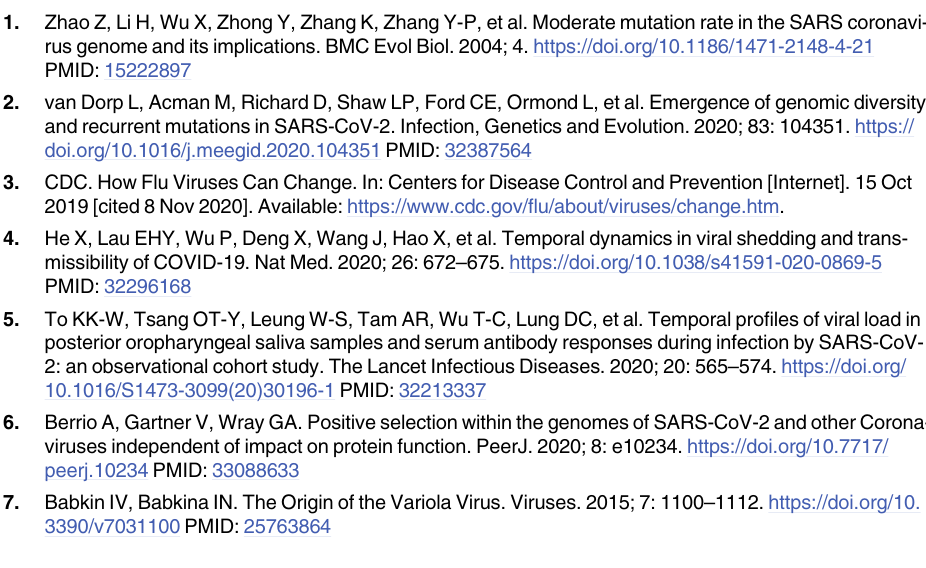
S1 Table. Evolutionary rates of pathogenic RNA viruses. S2 Table. Antibody escape mutants with highest ACE2 binding affinities. S3 Table. Antibody structures